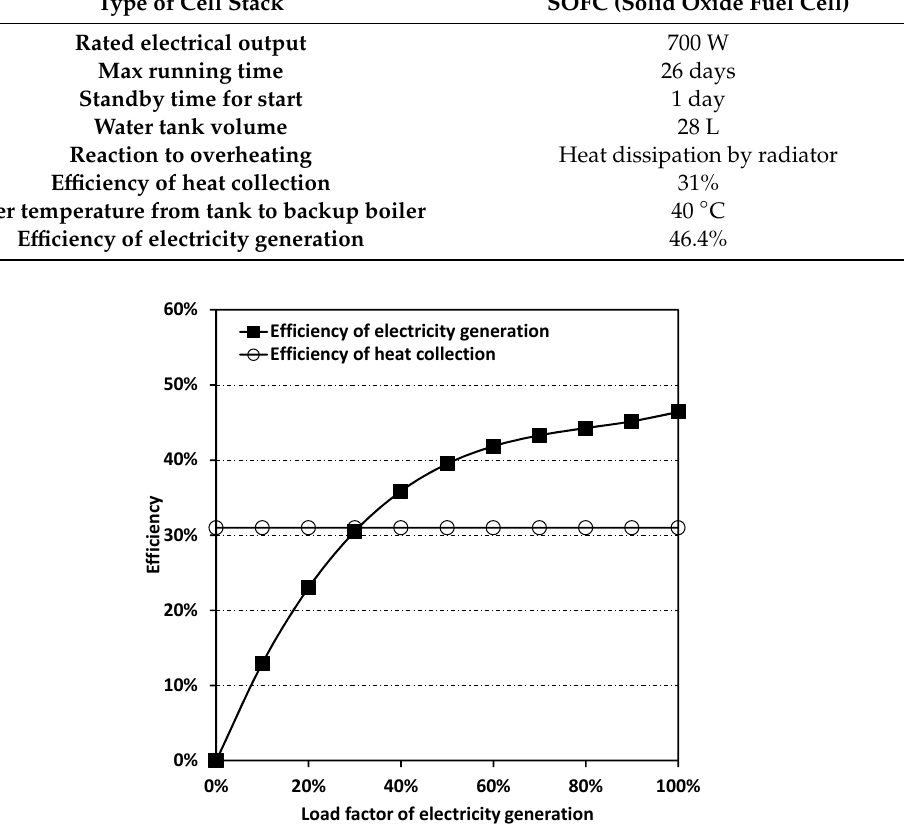
Figure 5. Efficiency of the SOFC–CGS. Figure 5. E ffi ciency of the Table 6. Specifications of the SOFC–CGS.